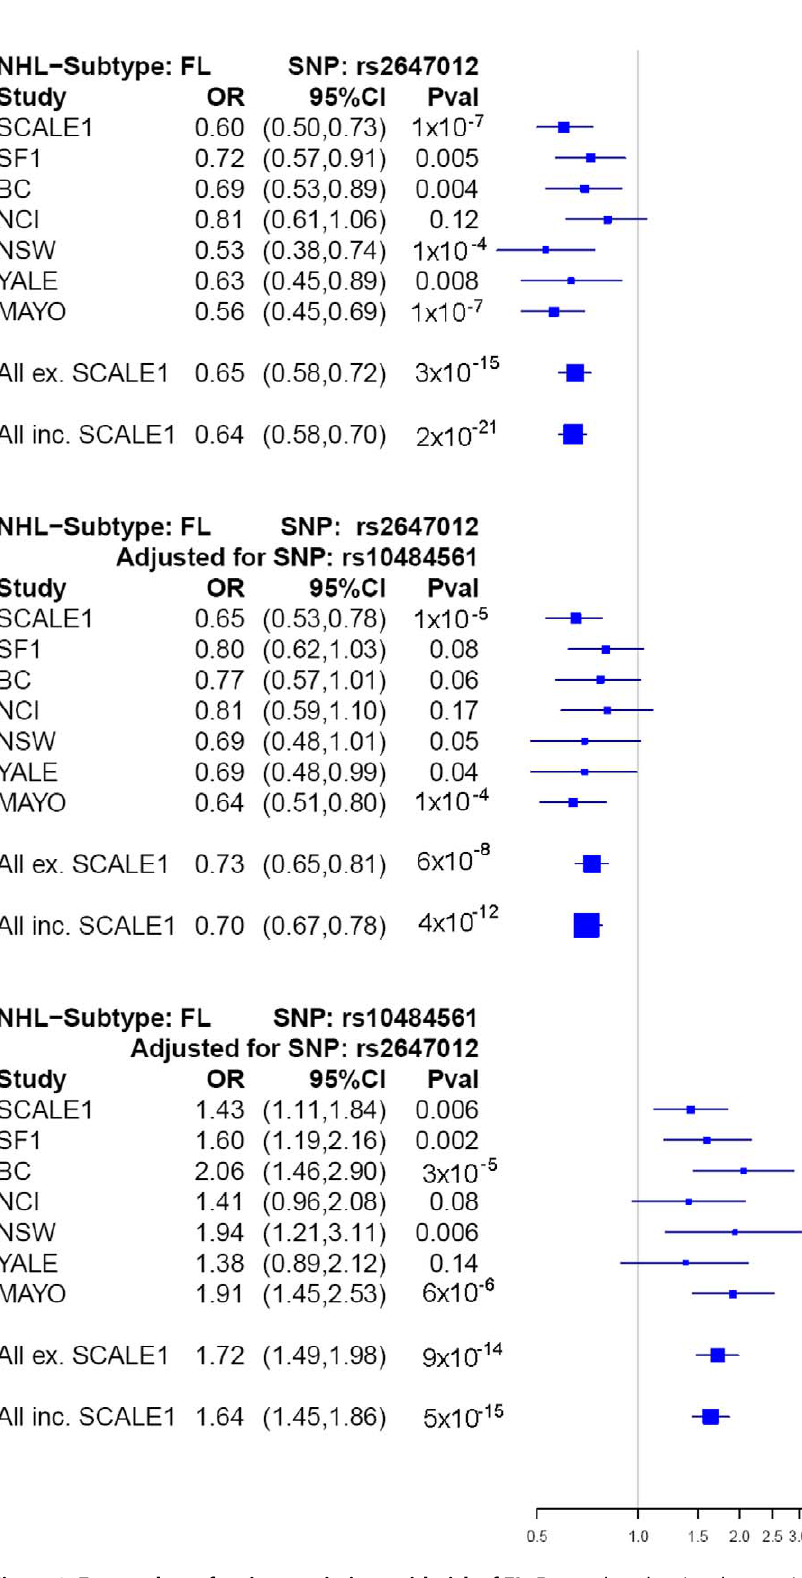
PLoS Genetics | www.plosgenetics.org 7 April 2011 | Volume 7 | Issue 4 |